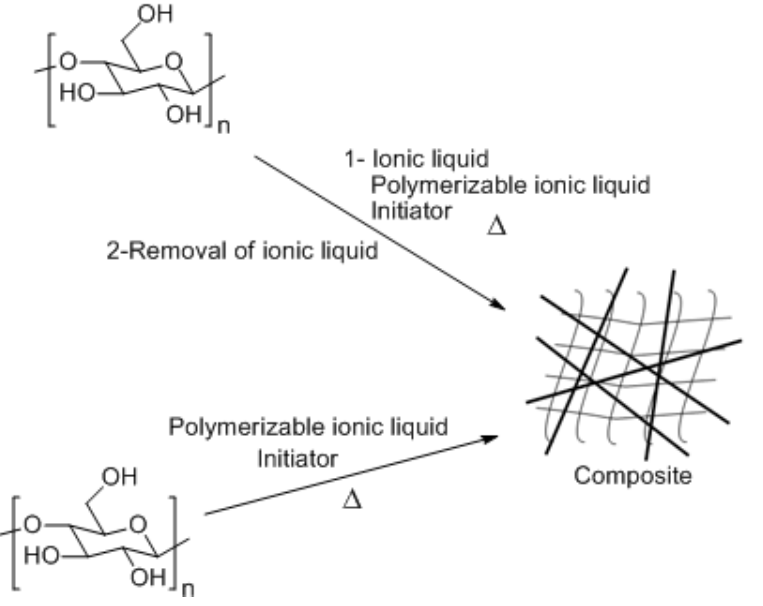
Figure 4. Two main approaches to obtain cellulose-poly (ionic liquid) composites. Δ = heat given to the